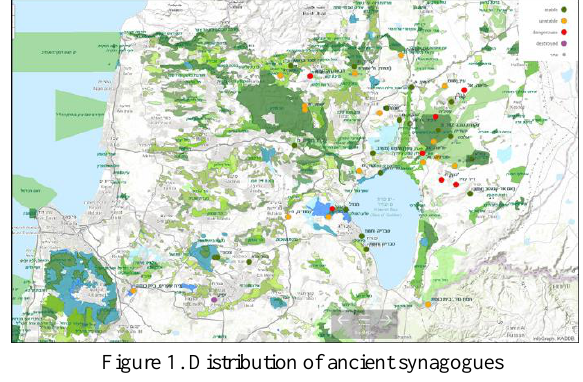
Figure 1. Distribution of ancient synagogues according to the different stake holders in relation to their physical condition.